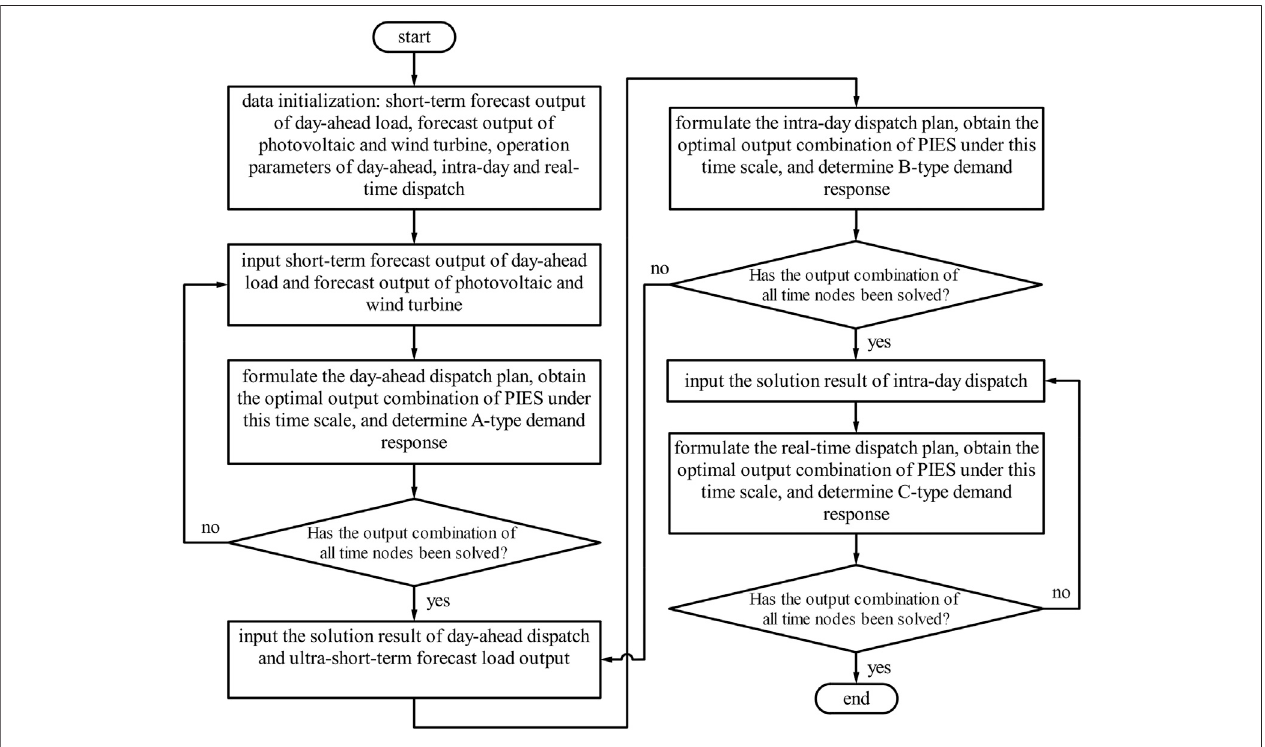
FIGURE 3 | The optimal dispatch solution process of PIES.